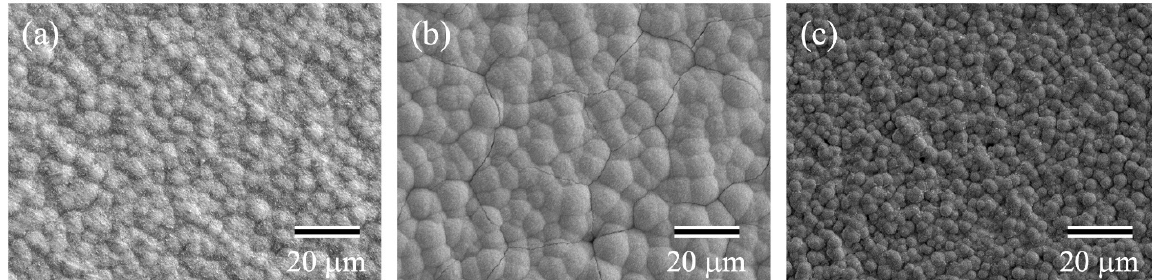
Figure 3. SEM microstructures of the HW-treated anodic oxides. Representative images of the SEM microstructures of HW-treated anodic oxides prepared in the electrolyte with acetic acid. Acetic acid concentration: ( a ) 1 M; ( b ) 2 M; ( c ) 6 M. SEM: Scanning electron microscopy; HW: Hot water. (reprinted from Ref. [57] with permission).